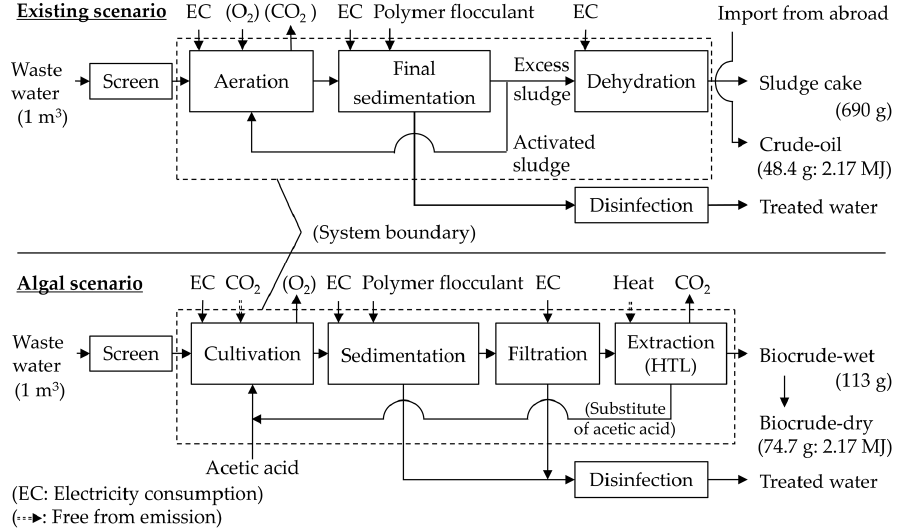
Figure 1. System boundary for existing and algal scenarios.